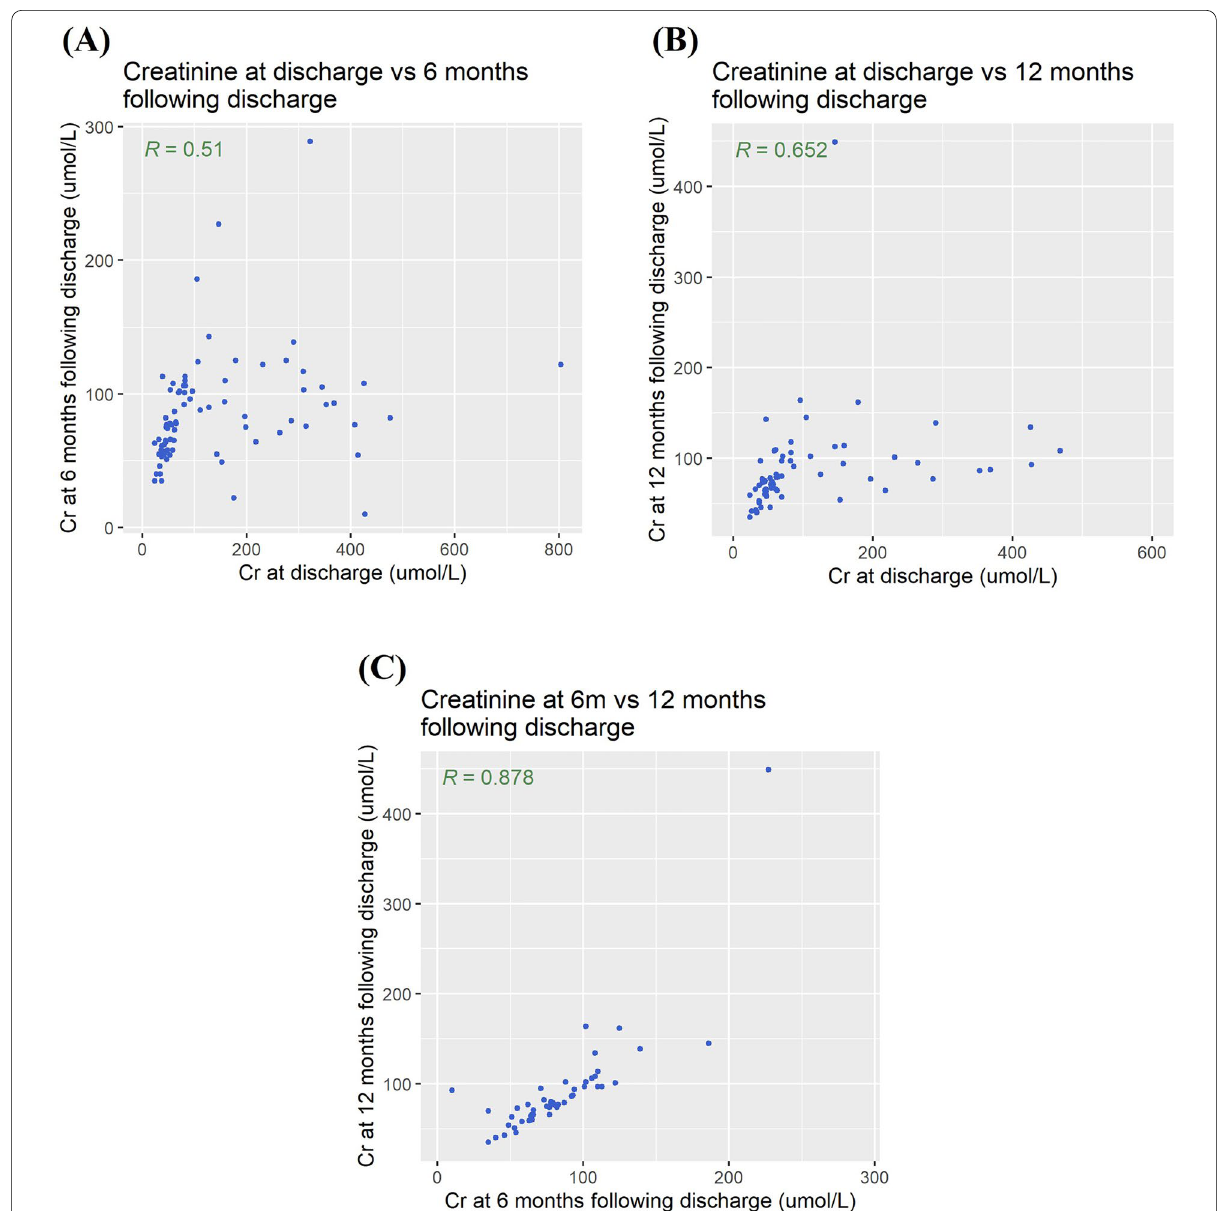
Fig. 2 Scatter plots and Spearman’s rank correlation coefficients comparing creatinine at hospital discharge and at 6 months ( n 12 months ( n 65) ( B ) following hospital discharge and between creatinine at 6 and 12 months ( n = with available creatinine